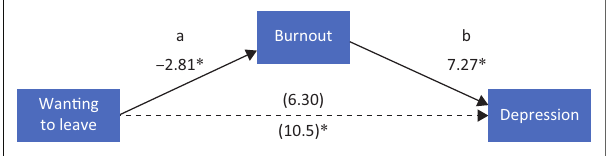
FIGURE 1: Mediation analysis.